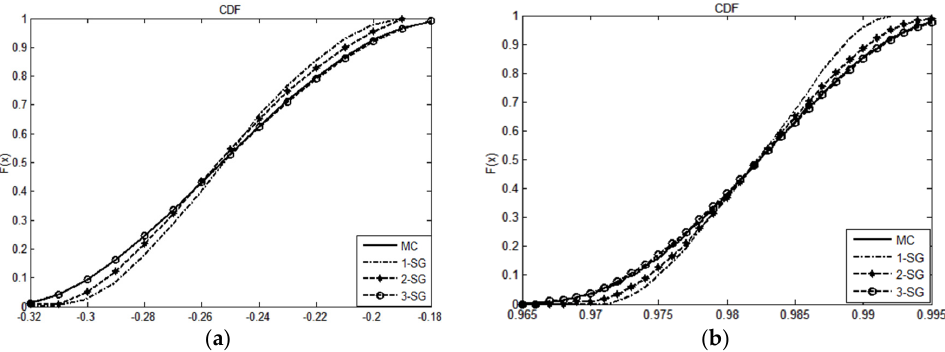
V under 1–3 order in IEEE ‐ 14 system: ( a ) Figure 6. CDFs of 4  and Figure 6. CDFs of θ 4 and V 4 under 1–3 order in IEEE-14 system: ( a ) θ 4 p rad q ; ( b ) V 4 p p.u. q . 4